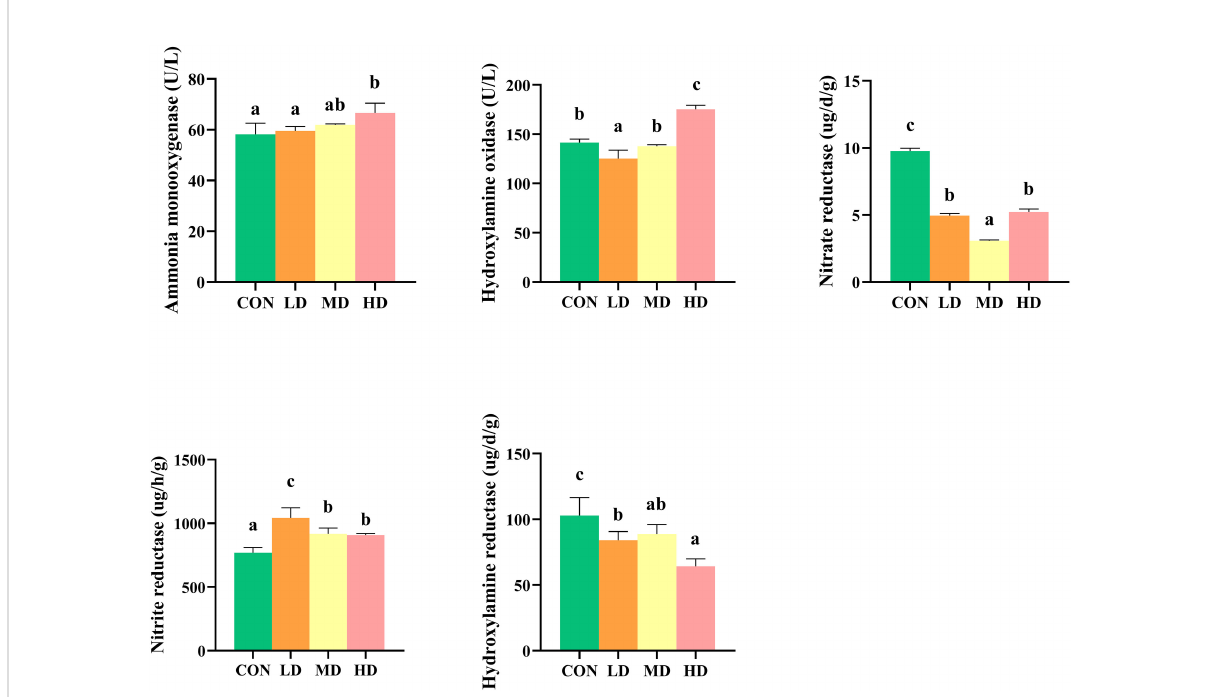
FIGURE 2 Differences in sedimentary extracellular enzyme activity between the CON, LD, MD and HD groups during the experimental period, including nitrate reductase, nitrite reductase, hydroxylamine oxidase, hydroxylamine reductase, and ammonia monooxygenase. Different lowercase letters represent signi fi cant differences between the CON, LD, MD, and HD groups ( P <